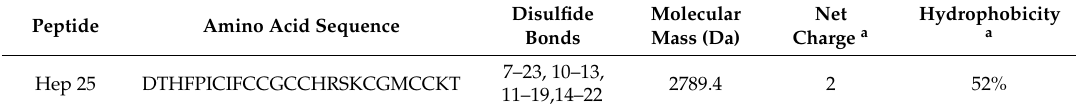
Table 1. Amino acid sequence and physicochemical properties of Hep25.